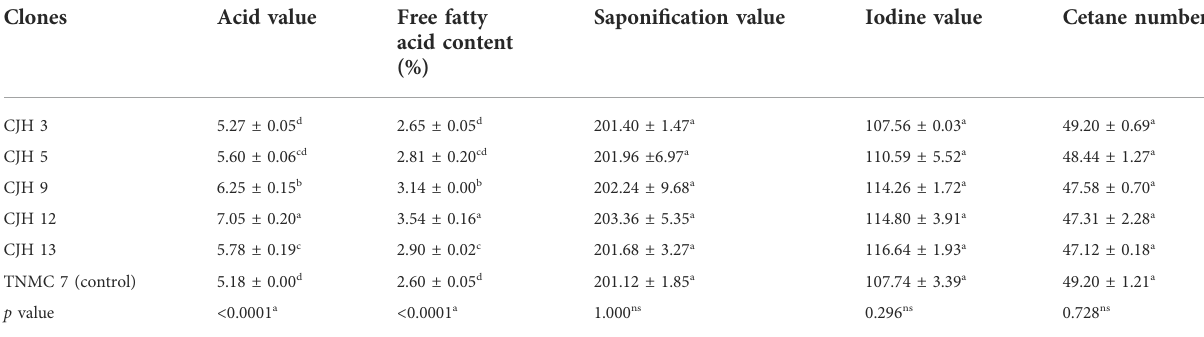
TABLE 7 Biochemical Properties of Jatropha hybrid clones.